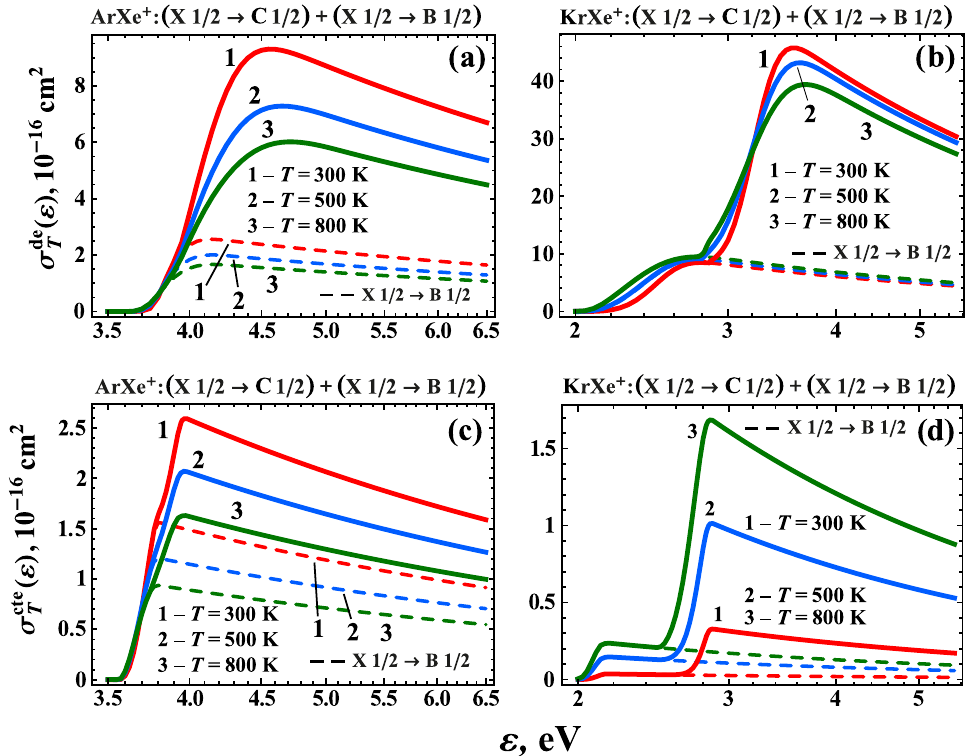
Figure 7. Cross sections of dissociative excitation (1) and electron-impact bound–bound excitation (2) processes accompanied by transitions to charge transfer terms as functions of the incident electron energy for both A - and B - types of non-adiabatic transitions in ArXe + and KrXe + ions at gas temperatures T = 300, 500 and 800 K. ( a ) Cross sections of dissociative excitation in collisions involving ArXe + . ( b ) Cross sections of dissociative excitation in collisions involving KrXe + . ( c ) Cross sections of bound–bound excitation in collisions involving ArXe + . ( d ) Cross sections of bound–bound excitation in collisions involving KrXe +